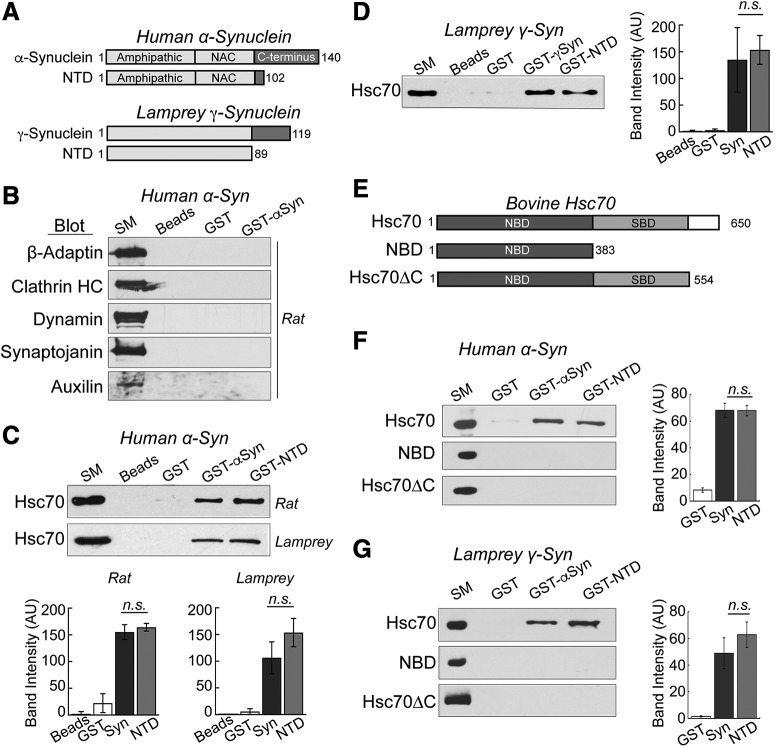
α-Synuclein interacts directly with Hsc70, the chaperone protein that uncoats CCVs during synaptic vesicle recycling. A, Domain diagrams of full-length human α-synuclein, lamprey γ-synuclein and their respective NTDs. B, GST pull downs from rat brain lysates revealed no detectable interactions between α-synuclein and several major components of CME including AP2, clathrin, dynamin, synaptojanin, and auxilin. SM = starting material. Blots shown are representative of n = 3 experiments. C, In contrast, human α-synuclein and its NTD pulled down Hsc70 from rat brain and lamprey CNS lysates. D, Similarly, lamprey γ-synuclein pulled down Hsc70 from rat brain lysates, demonstrating conservation of the interaction. E, Domain diagrams of bovine Hsc70 and several truncations used in the experiments. F, G, In direct binding assays, both human α-synuclein and lamprey γ-synuclein, and their NTDs, pulled down recombinant bovine Hsc70. No interactions were detected with either NBD or Hsc70ΔC, indicating a role for the C terminus. In panels C, D, F, G, bars represent mean ± SEM from n = 3 independent experiments. n.s. = not significant by ANOVA (p > 0.05).